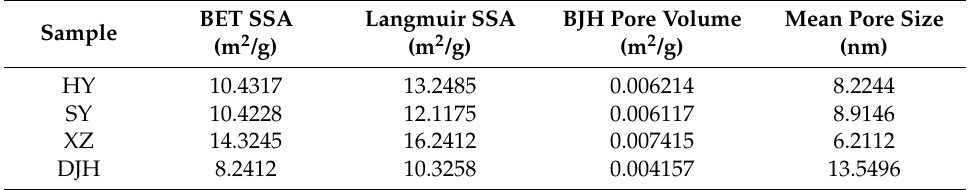
Characteristics of pore distribution in coal